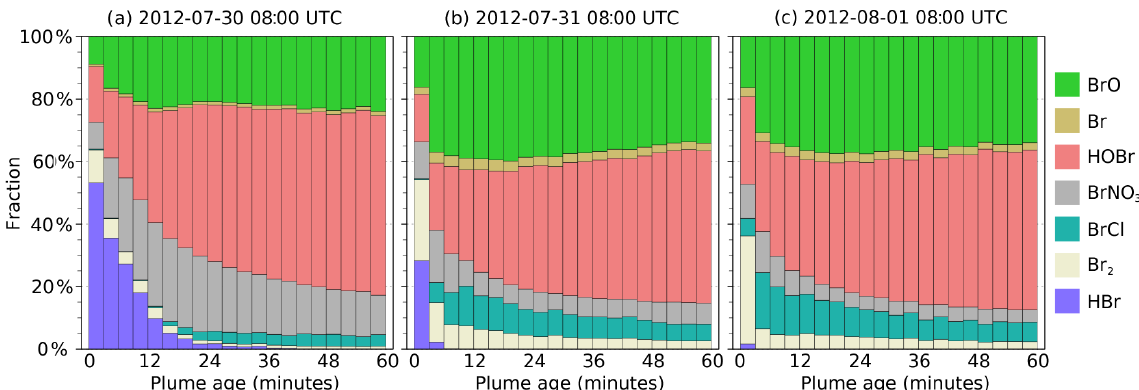
Figure 9. Differentiation of bromine between species for parts of the plume at different ages ranging from 0–60min for plumes at 08:00UTC on (a) 30 July 2012, (b) 31 July 2012, and (c) 1 August 2012.